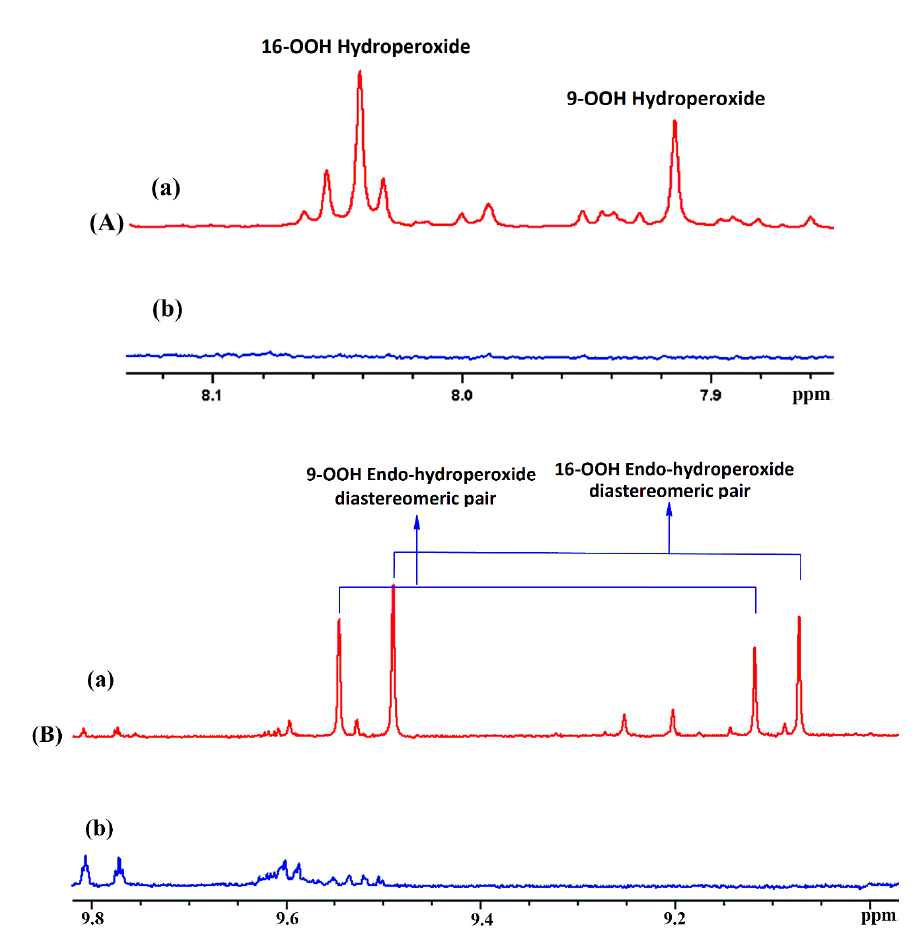
Figure 2. 800 MHz 1 H-NMR spectra of the solution of Figure 1 before the addition ( a ), and after the addition ( b ) of 2 microdrops of D 2 O. ( A ) and ( B ) are the selected regions of the 7.86 to 8.14 and 8.96 to 9.82 ppm, respectively. For the method of assignment of the -OOH resonances, see text.